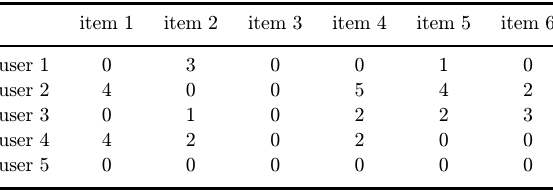
Table 1. Example of a user-to-item rating